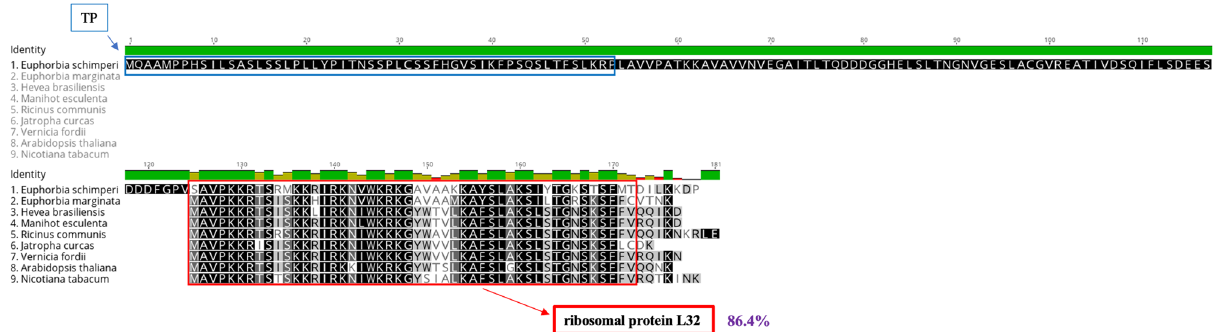
Figure 1. Multiple alignments of nuclear RPL32 of Euphorbia schimperi and plastid RPL32 of other Euphorbiaceae ( E. marginata, Jatropha curcas, Hevea brasiliensis, Manihot esculenta, Ricinus communis, Vernicia fordii), Arabidopsis thaliana and Nicotiana tabacum. Blue box indicates plastid transit peptide (TP) predicted using LOCALIZER (~ 53 aa). Red box indicates a conserved domain of RPL32. Pairwise amino acid sequence identity of the conserved domain of nuclear-encoded RPL32 of E. schimperi and pt-encoded copies in Euphorbiaceae species and Arabidopsis thaliana and Nicotiana tabacum was 86.4%.Green histogram indicates amino acid sequence